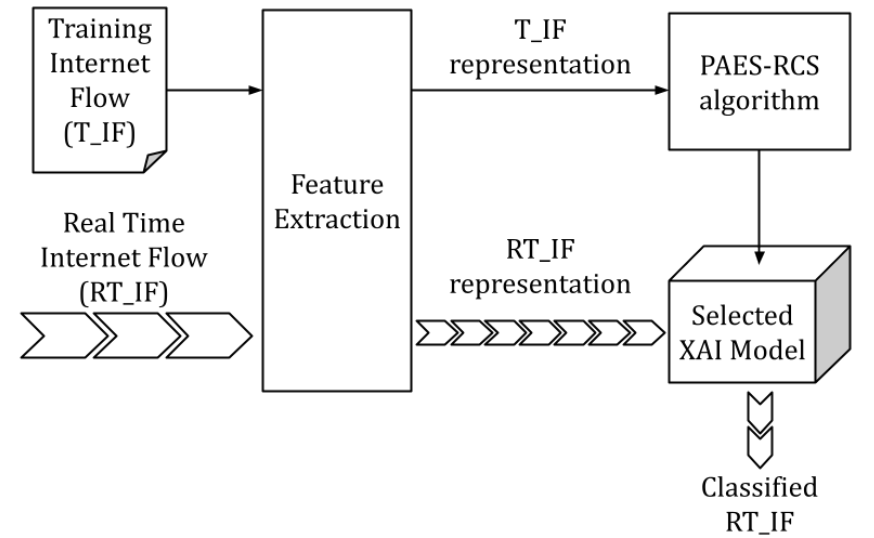
Figure 1. Block diagram of the proposed Traffic Classification